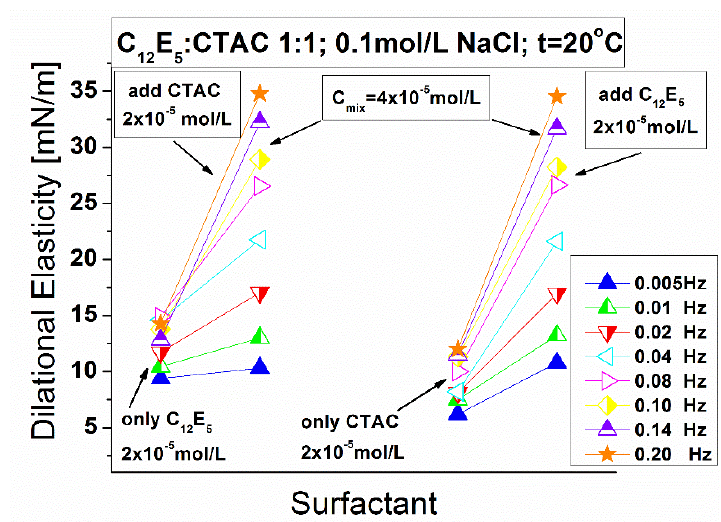
Figure 12. Dilatational elasticity change after addition of second component: C 12 E 5 is added to existing CTAC adsorption layer; CTAC addition to C 12 E 5 adsorption layer; final mol:mol ratio is 1:1 for the mixture with total surfactant concentration of 4.0 × 10 −5 mol/L.